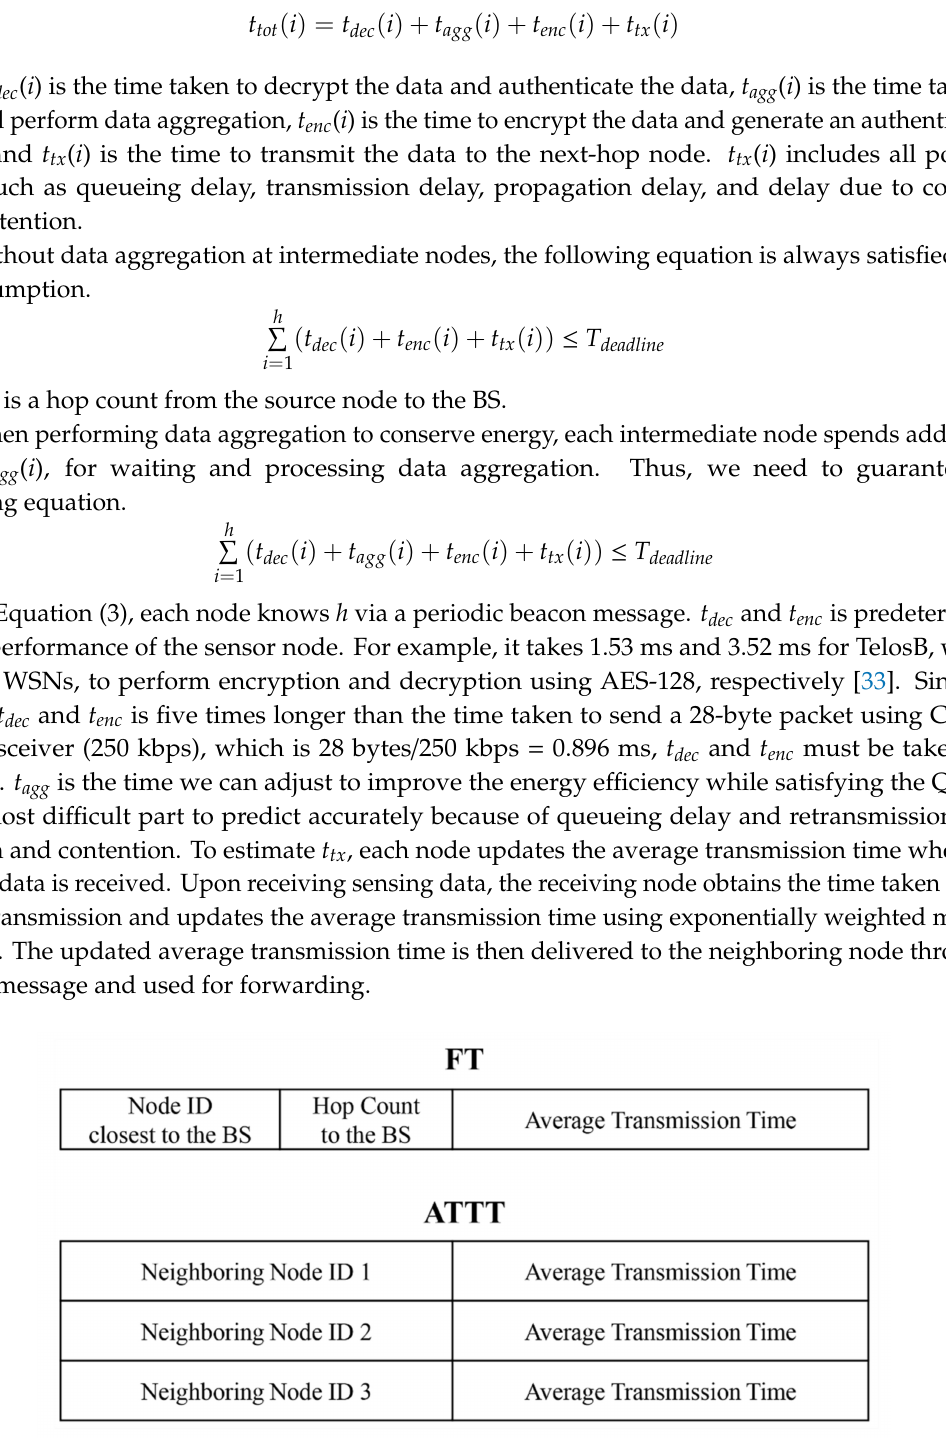
Figure 2. The structure of forwarding table (FT) and average transmission time table